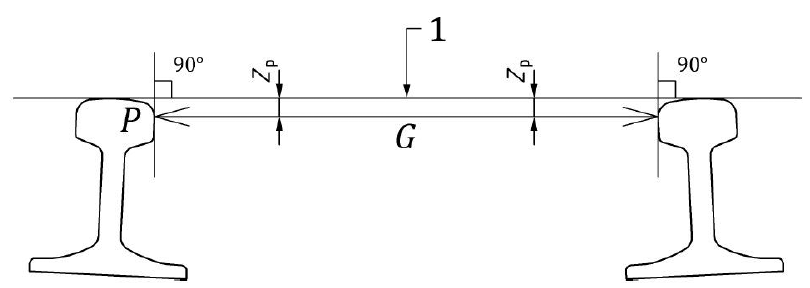
Figure 16. Track gauge in case of a newly built track (MSZ EN 13848-1, 2019)